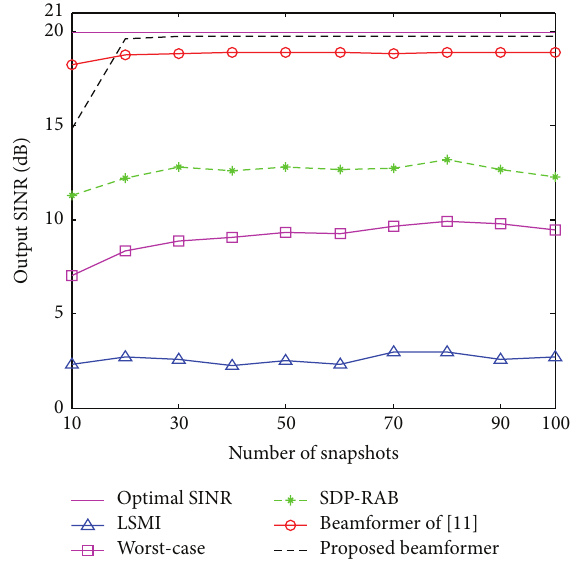
Figure 6: Output SINRs versus the number of snapshots in the case of wavefront